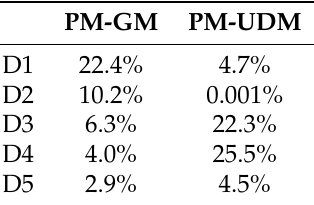
Table 4. Difference of average overall recall (from 1% to 30% of labeled data) between the Personalized Model and the other two models. PM: Personalized model; GM: General model; UDM: User-dependent model.